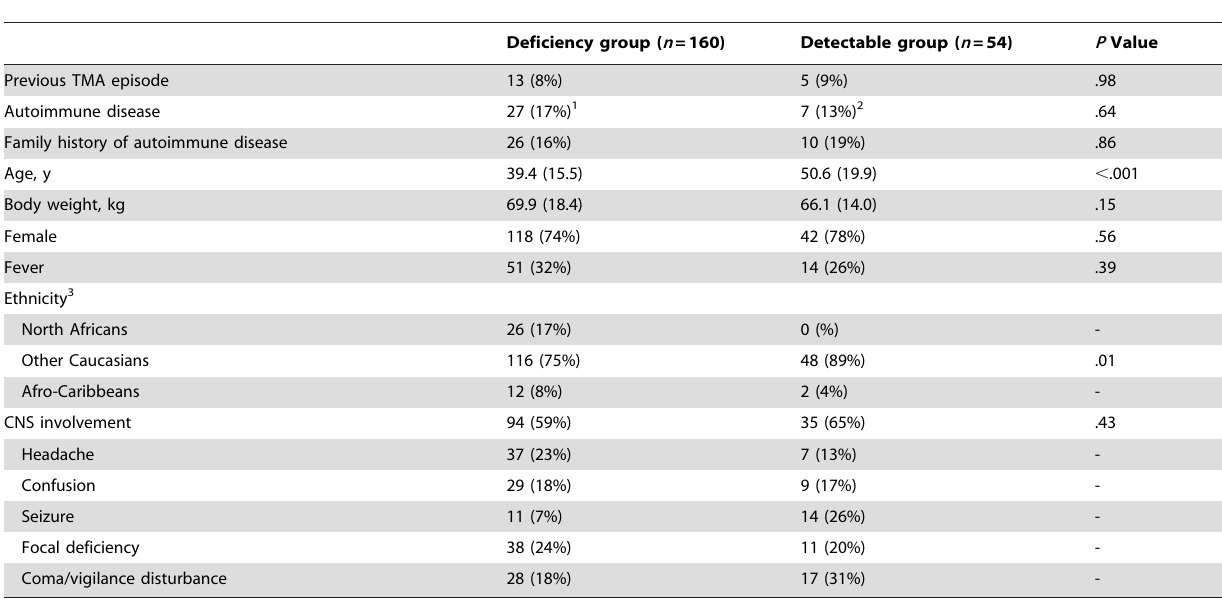
Table 1. Clinical Characteristics of 214 Patients with Thrombotic Microangiopathy According to ADAMTS13 Activity.